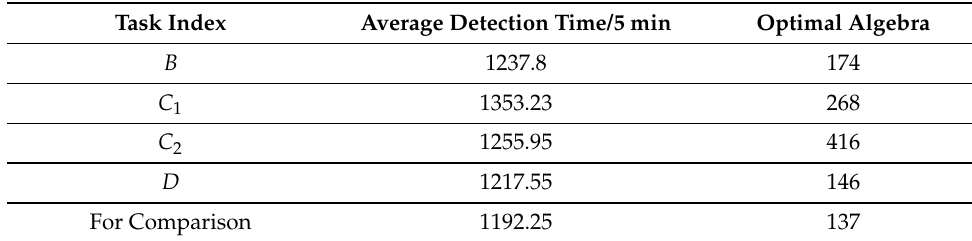
Figure 5. Domain knowledge comparison-based ERL. Table 3. Algorithm